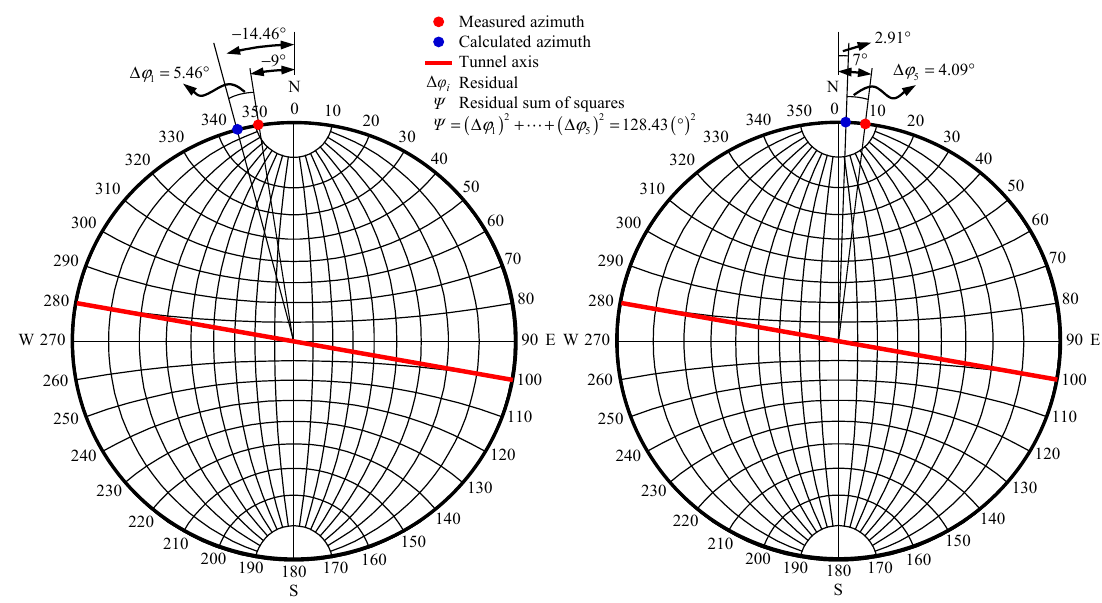
Figure 12. The comparison of in situ stress orientations without considering